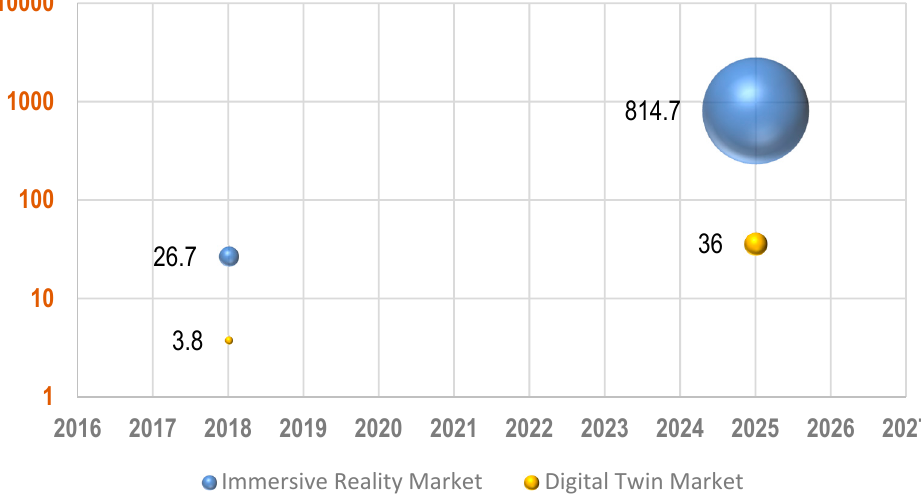
Figure 1. The increase in developing immersive reality and digital twin markers by 2025. Note: units are USD billion.